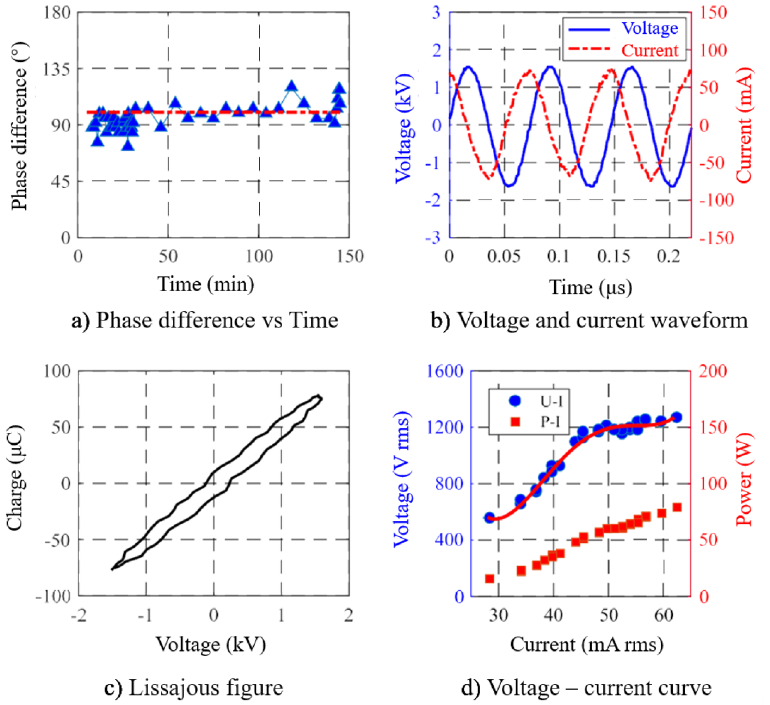
Figure 2. Discharge characteristics of the APPS